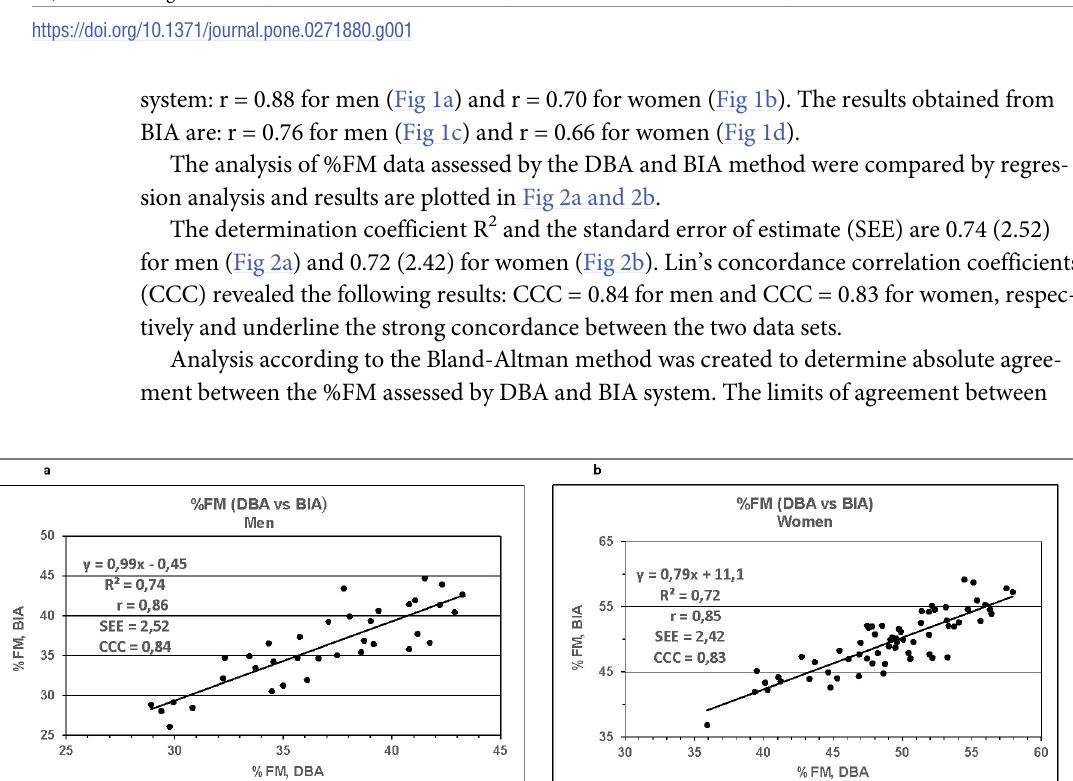
Fig 2. a and b: Relationship of %FM derived by BIA and DBA method of men (Fig 2a) and women (Fig 2b). Solid line: regression line; R 2 : determination coefficient; r: Pearson´s correlation coefficient; SEE: standard error of estimate; CCC: Lin‘s concordance correlation coefficients are